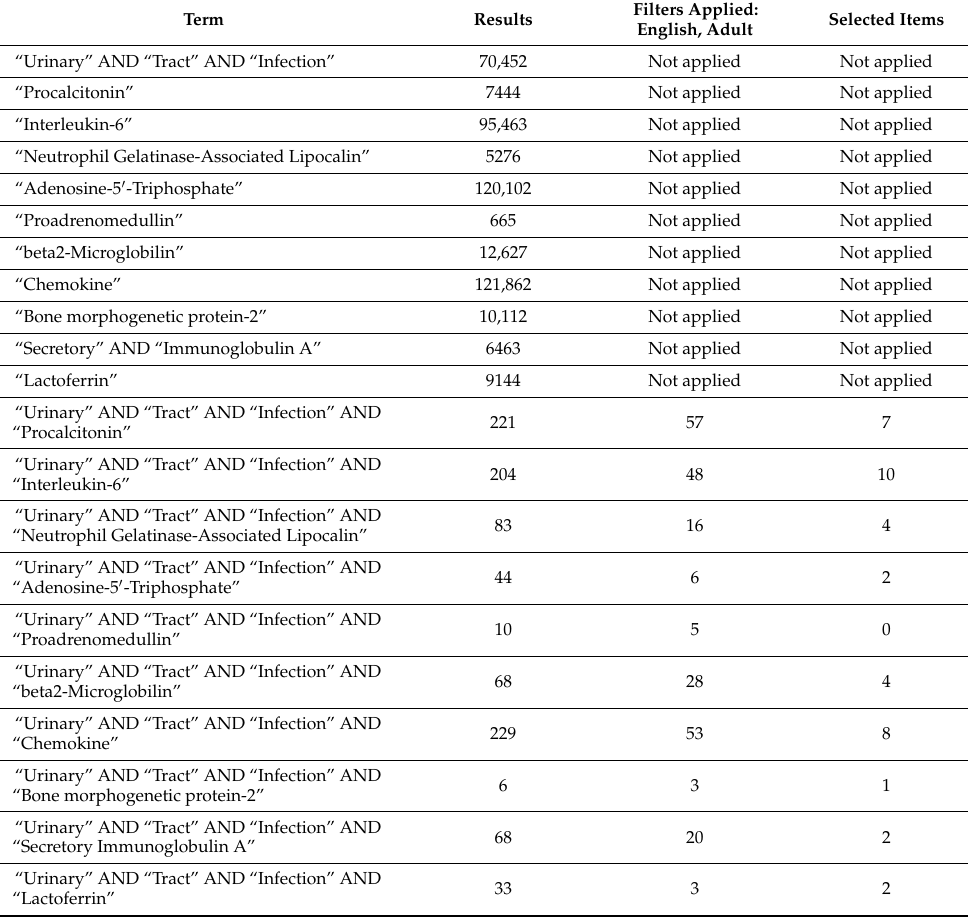
Table A1. Research Strategy for Each